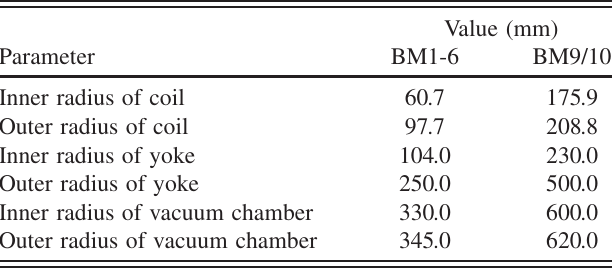
TABLE III. Dimensions of the coil, yoke, and vacuum cham- ber for the superconducting magnets.